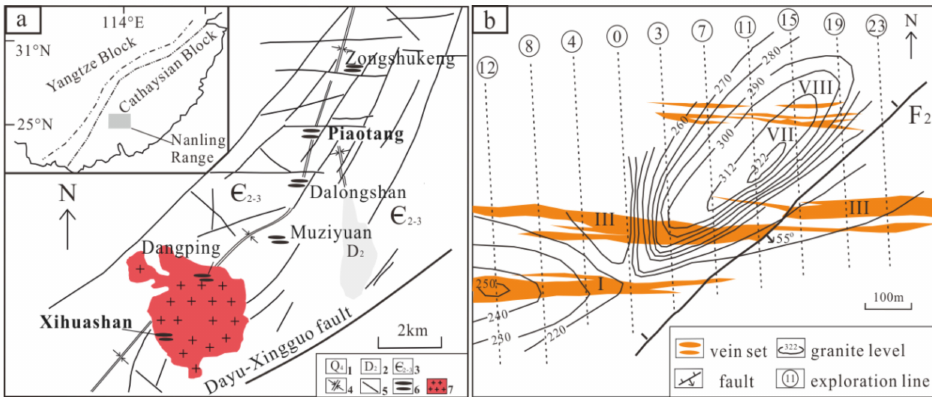
Figure 2. ( a ) A regional geological map of the Xihuashan–Piaotang mineralization belt (revised from [30]); ( b ) a planar view of the Piaotang deposit (revised from [31]). 1, Quaternary; 2, Middle Devonian; 3, Middle–Upper Cambrian; 4, axes of syncline; 5, fault; 6, vein–type tungsten deposits; 7,